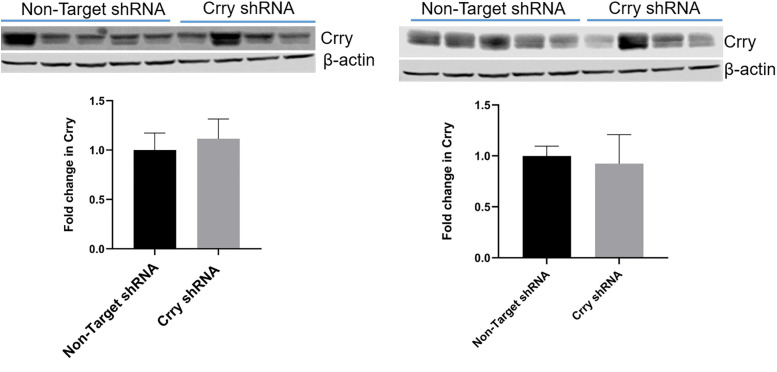
Decrease in Crry expression was placenta specific.Lentiviral vectors enclosing Crry or non-target shRNA were injected into right uterine horn of pregnant mice (n = 5–7) on 3.5 dpc, shRNA was induced on 10.5 dpc. Expression of Crry on 17.5 dpc in uterine tissue and liver was analyzed. Left panel is representative Western blot showing Crry levels in uterine tissue and density analysis. Right panel is representative Western blot showing Crry levels in liver and density analysis.